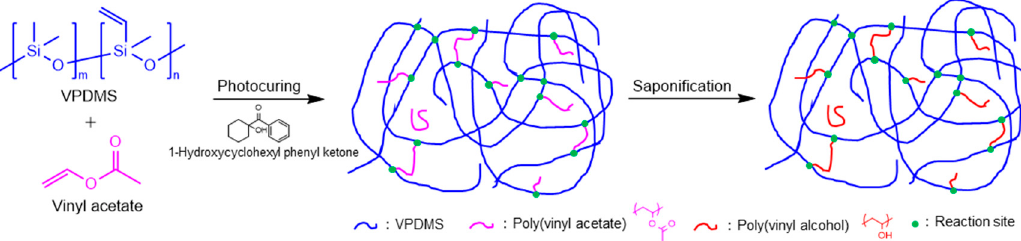
Scheme 2. Schematically depicted reaction of VPDMS with VAc during photocuring and saponification reaction of PVAc in the UV-cured film.